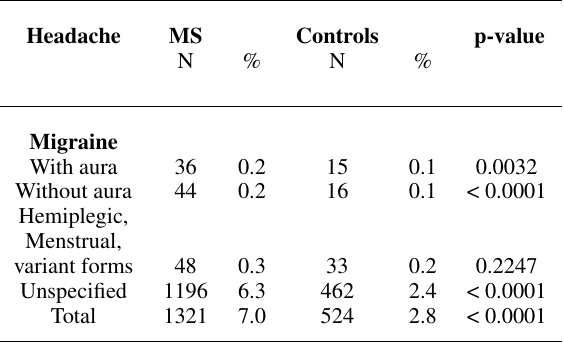
Table 2. Distribution of headache between MS and